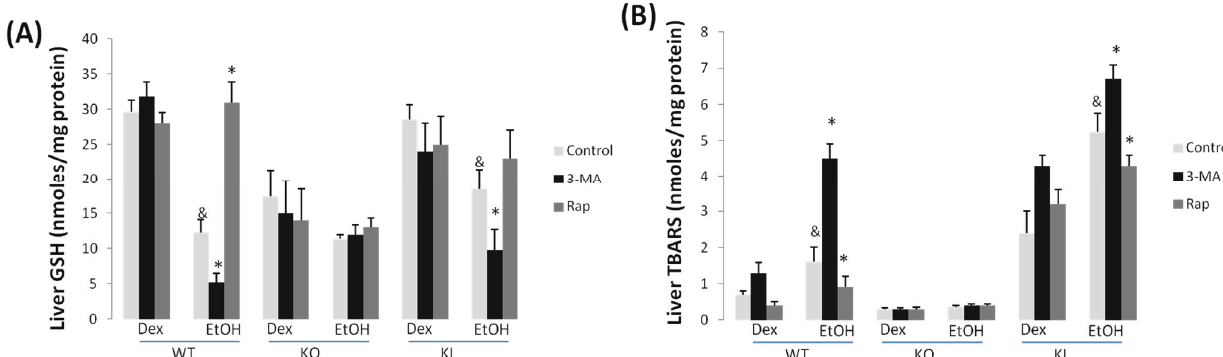
Figure 3. 3-MA enhances while rapamycin blunts oxidative stress in chronic alcohol-fed WT and KI mice. GSH levels ( A ) in WT, KO and KI mice. 3-MA potentiates the decline in GSH produced by ethanol whereas rapamycin prevents this decrease of GSH in WT and KI mice; TBARS ( B ) are elevated by ethanol feeding in WT and KI but not in KO mice. 3-MA enhances ethanol induced TBARS but rapamycin lowers this increase. &, p < 0.05 compared with dextrose control; *, p < 0.05 compared with chronic alcohol alone, N = 4.